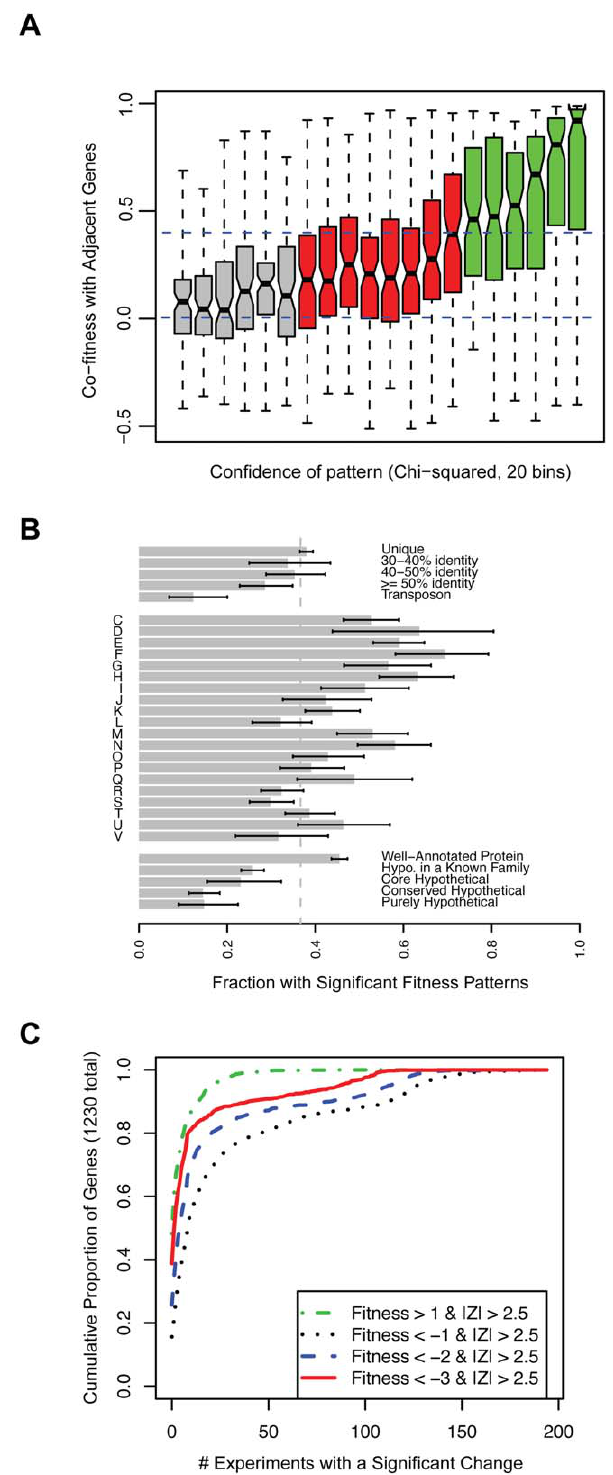
Figure 3. A phenotype for more than 2,000 genes in S. oneidensis MR-1. (A) Genes with more significant fitness patterns (higher chi-squared) tend to have stronger correlations with other genes in the same operon. We divided the genes into 20 bins by the significance (chi-squared) of their fitness patterns and for each bin we show a box plot of the correlations of those genes with adjacent genes that are predicted to be co-transcribed. The box shows the median and the interquartile range; the whiskers show the extreme values; and